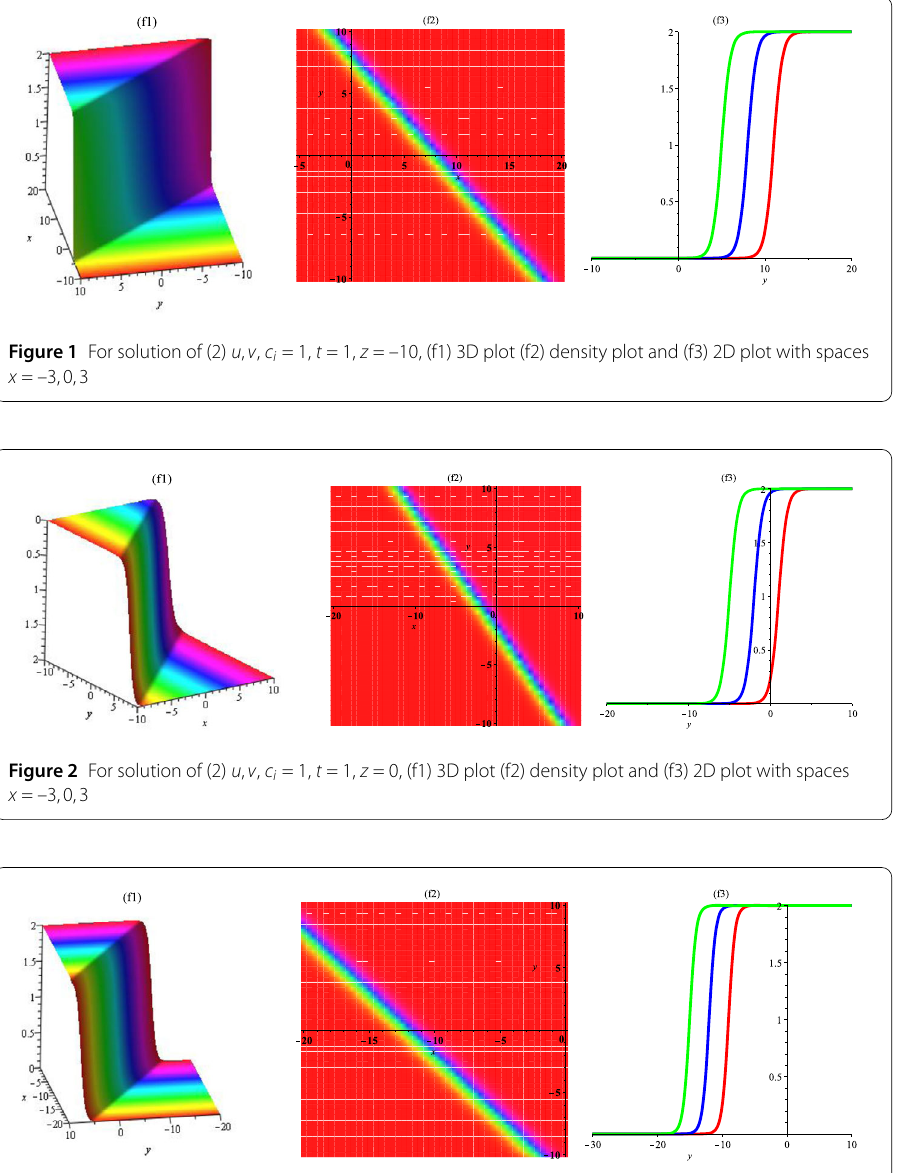
Figure 3 For solution of (2) u , v , c i = 1, t = 1, z = 10, (f1) 3D plot (f2) density plot and (f3) 2D plot with spaces x =